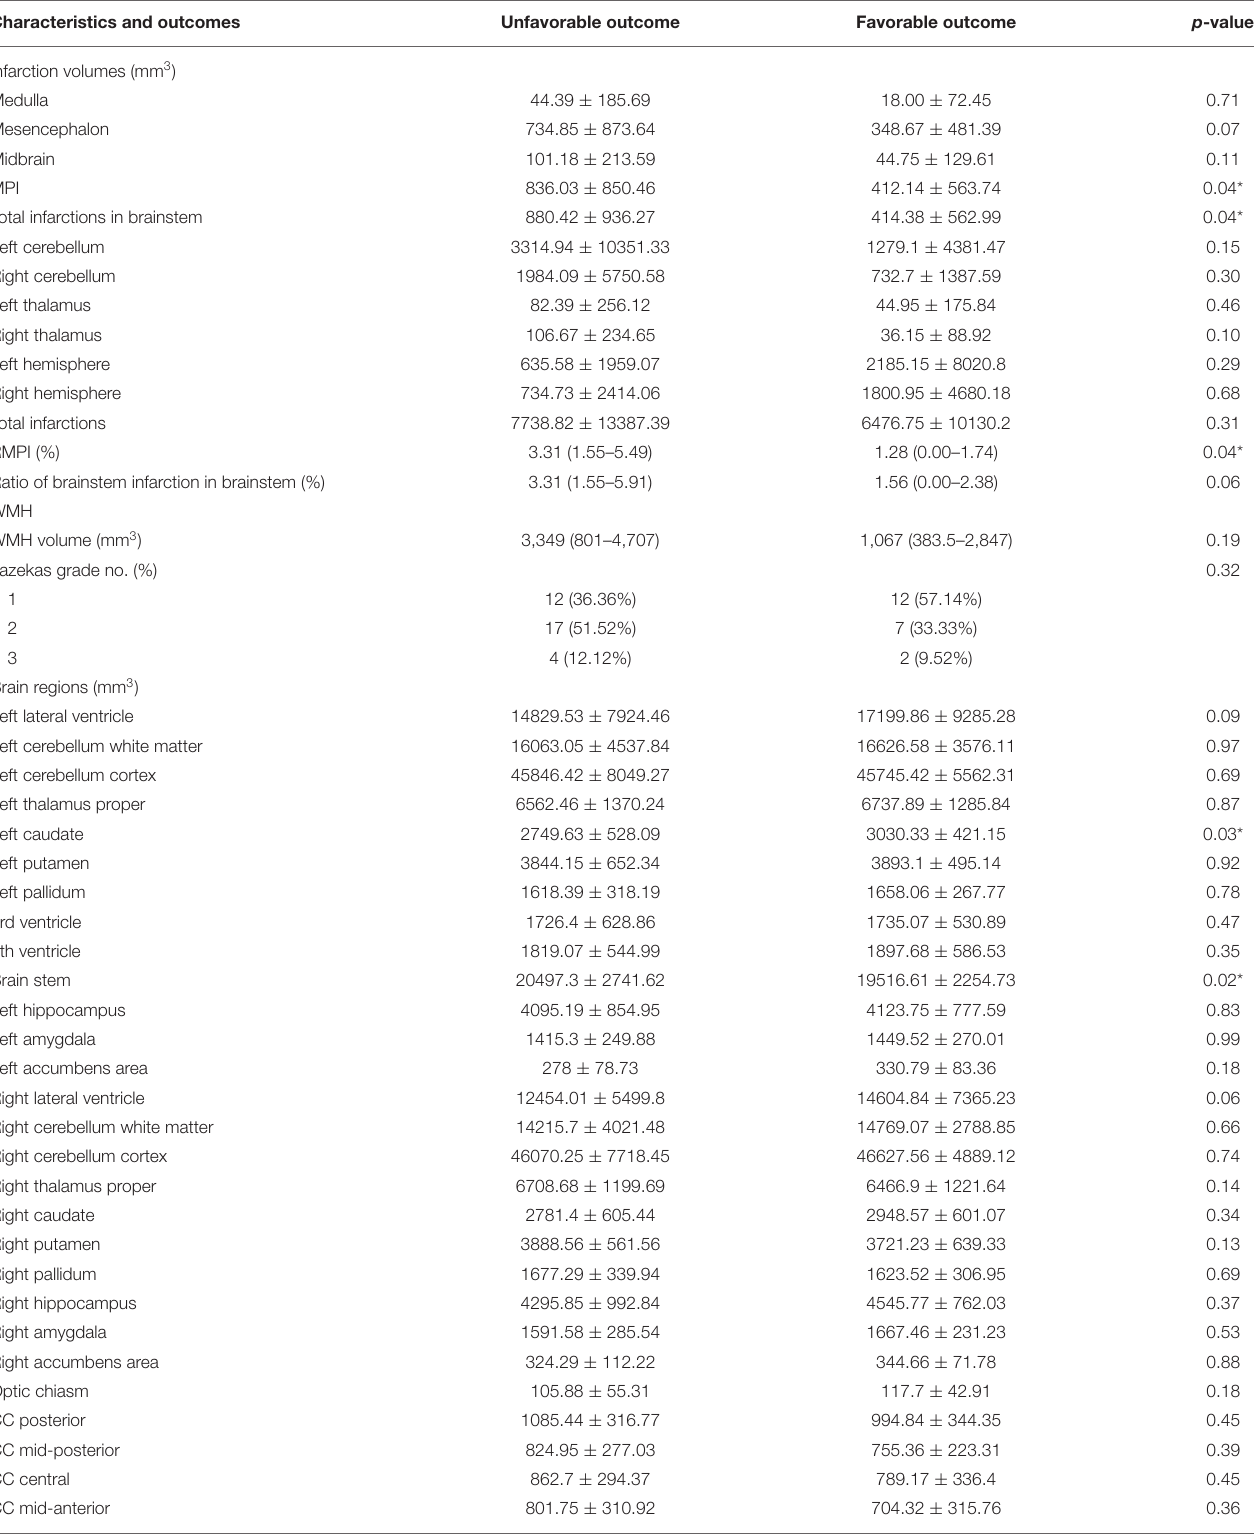
TABLE 2 | Predictors of neural markers for mRS level. Characteristics and